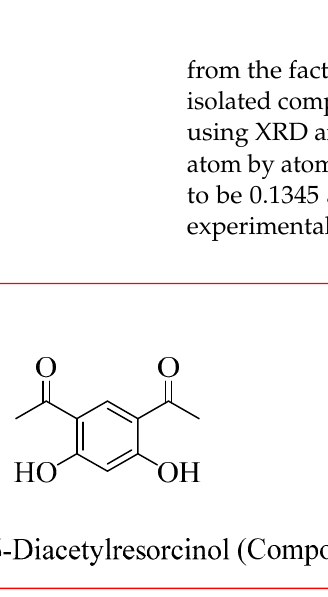
Figure 1. Isolated compounds ( 1 and 2 ) from Bixa orellana . leaves.